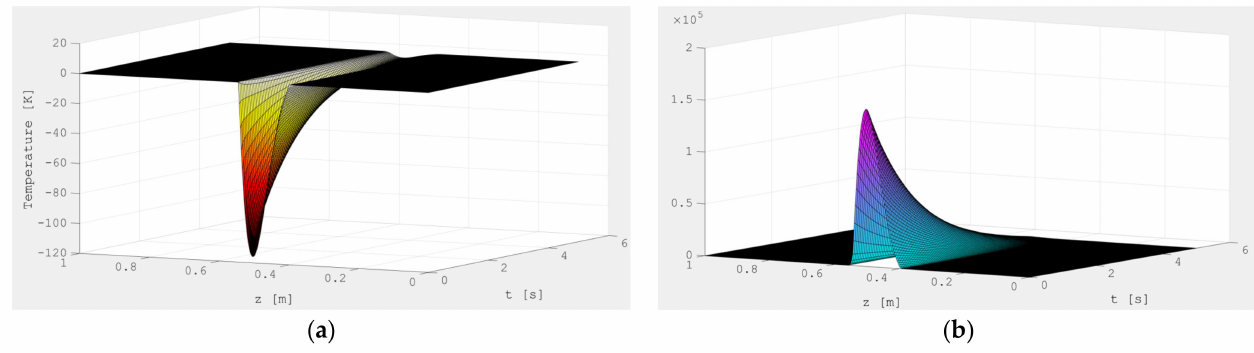
Figure 10. Surface graphs: ( a ) change in temperature ∆Θ ; ( b ) burner power ∆ u at τ = 5